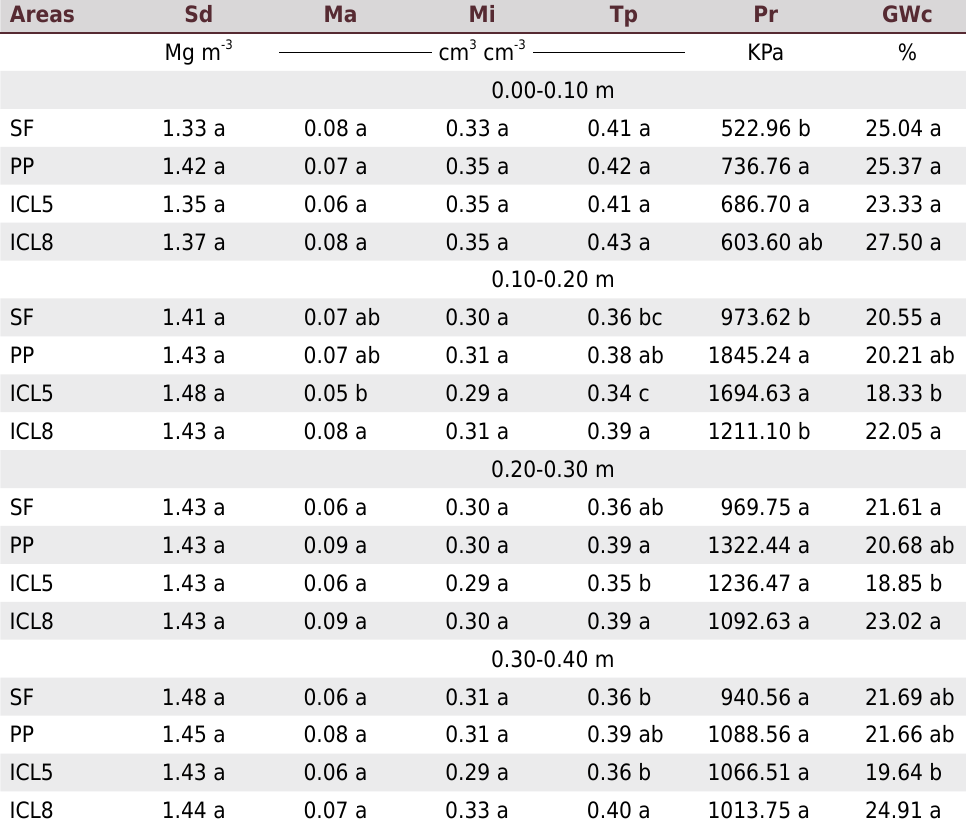
SF: Secondary Forest; PP: Perennial pasture; ICL5: Pasture recovered in integrated crop-livestock to five years; ICL8: Pasture recovered in integrated crop-livestock to eight years. Means followed by the same letter in the column for each layer do not differ from each other by the t-test (p<0.05).